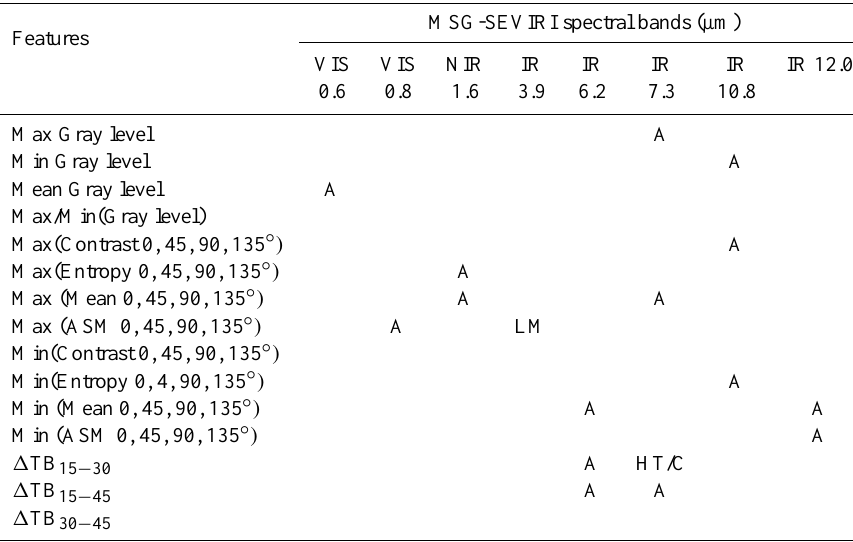
Table 5. Summary of the features considered for use in the RainCEIV k -NNM classifier during daytime. Label “A” means that the feature is used for all the C-MACSP classes; “LM” means that the feature is used for the low/middle cloud class; “HT/C” means that the feature is used for the high thick and convective cloud